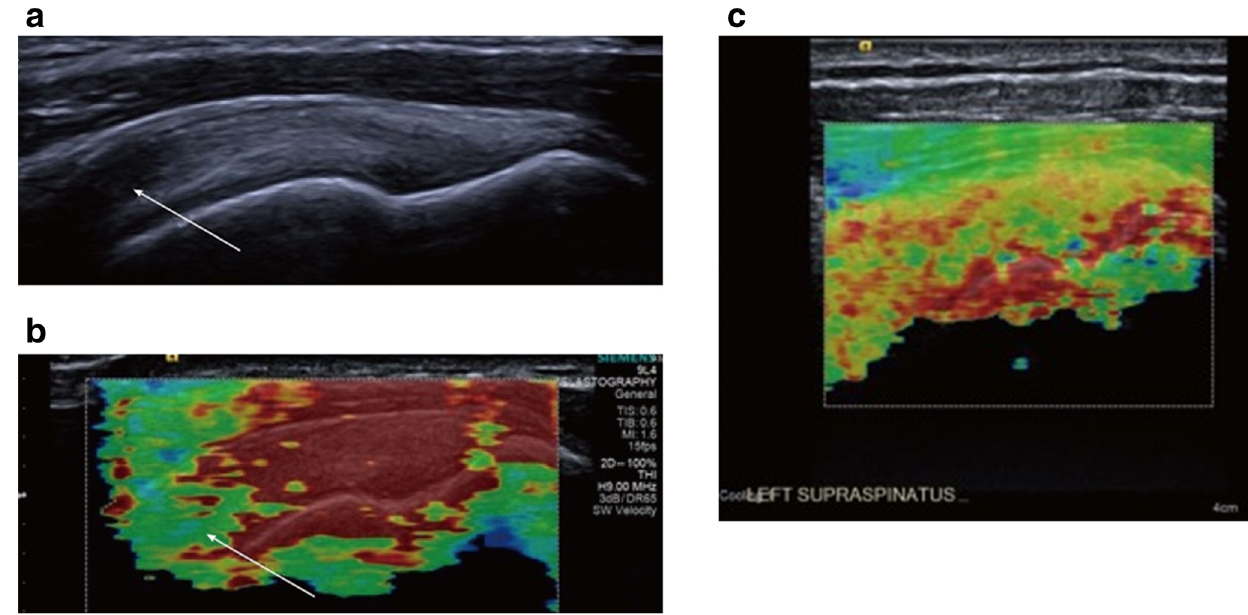
Fig. 6 Images of supraspinatus tendon using SWE. a Appearance of a normal supraspinatus tendon showing anisotropy (white arrow) due to curvilinear orientation of the tendon. b Corresponding elastogram showing heterogeneous stiffness in the region of anisotropy and absence of measurement in the deepest region in the humeral head (which is expected since it is a high stiffness structure with limited